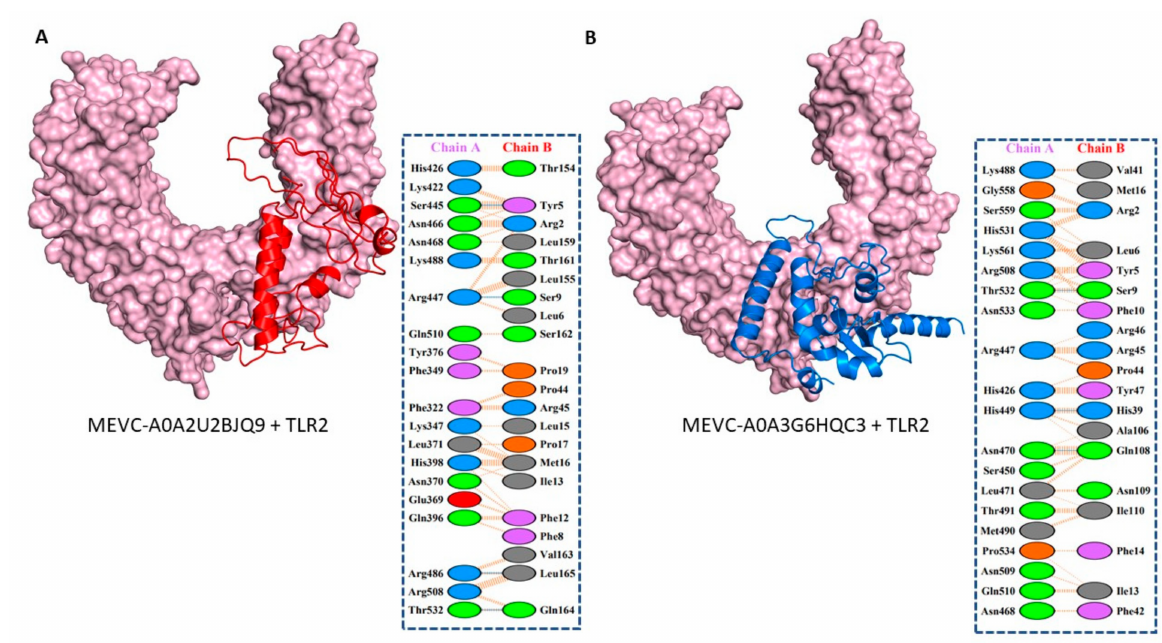
Figure 4. Demonstrates the docking complex and interaction patterns of each target-specific MEVC (red and blue), with the structure in the surface view (light pink color) represented as human TLR-2. Figure ( A ) shows the structural docking complex of MEVC-A0A2U2BJQ9 (red color) with human TLR-2 and the interaction patterns, while ( B ) shows the structural docking complex of MEVC-A0A3G6HQC3 (blue color) with human TLR-2 and the depicted interaction